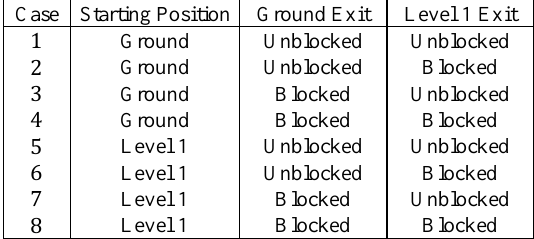
Table 3. Case setup for scenario 3